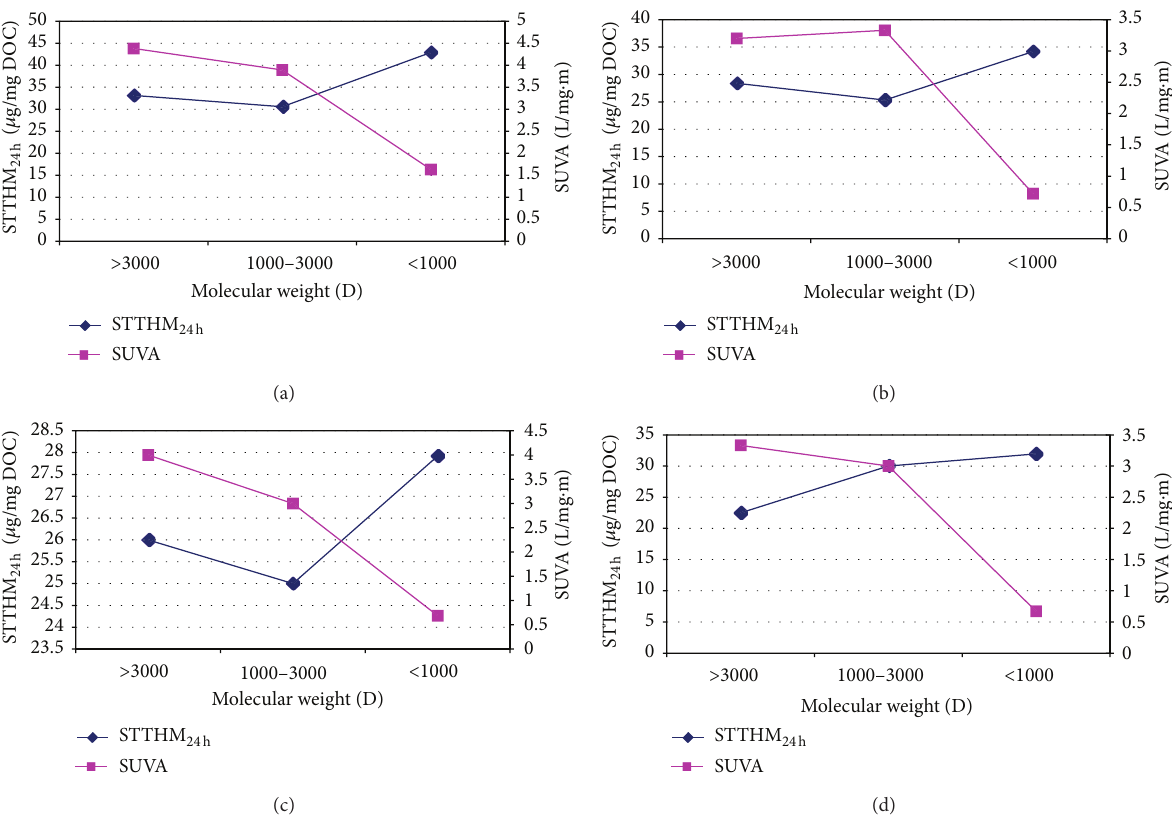
Figure4:VariationsoftheSUVA 254 andSTTHM 24 flocculation process, and (d) filtration process.